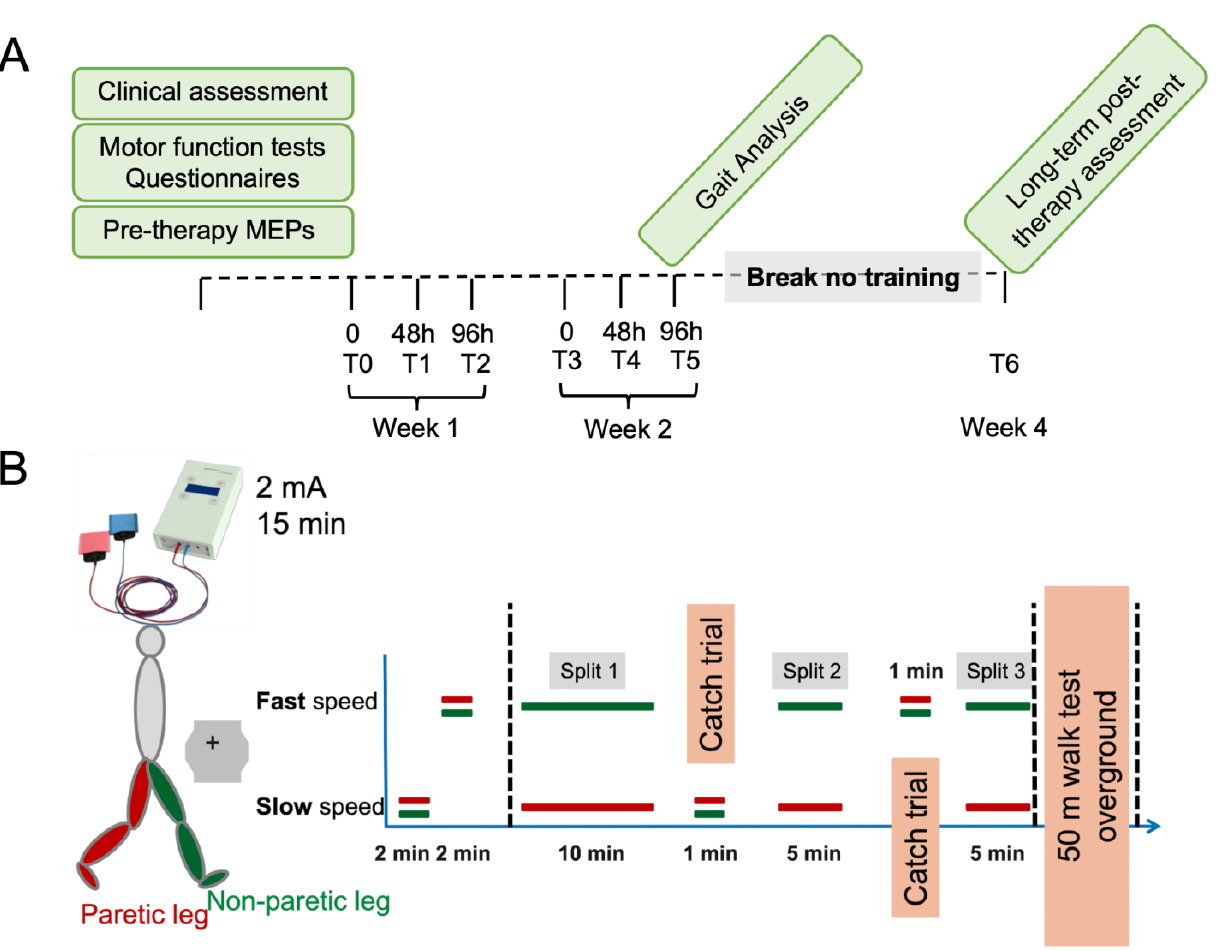
Figure 1 . Experimental design. ( A ) Baseline clinical assessments, motor function tests,